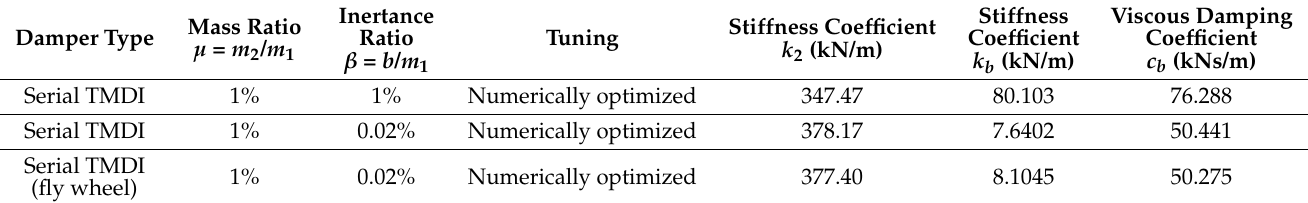
Table 4. Parameters of TMDIs with a serial arrangement of stiffness, inerter and viscous damper. Damper Type